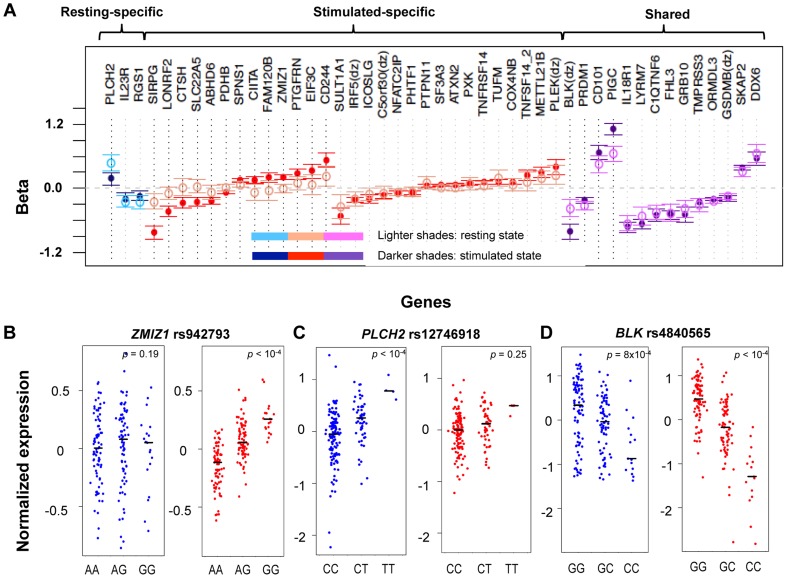
State-specific effects of eQTL SNPs.
A) For a subset of genes, the correlation effects (β) of the top associated SNP across resting and stimulated cells differed. The genes shown with a black-dotted vertical lines had significantly different effect sizes across states. Black horizontal segments in B)–D) denote median values. Blue panels show resting-state (normalized) expression values; red panels show stimulated expression values. B) rs942793G significantly increased the expression of ZMIZ1 only in stimulated cells. C) rs12746918T was correlated with increased expression of PLCH2 in resting cells only. D) rs4840565C decreased BLK expression in stimulated cells nearly twice as much as in resting cells [β
rest(SE) = −0.366(0.085), β
stim = −0.805(0.071)].